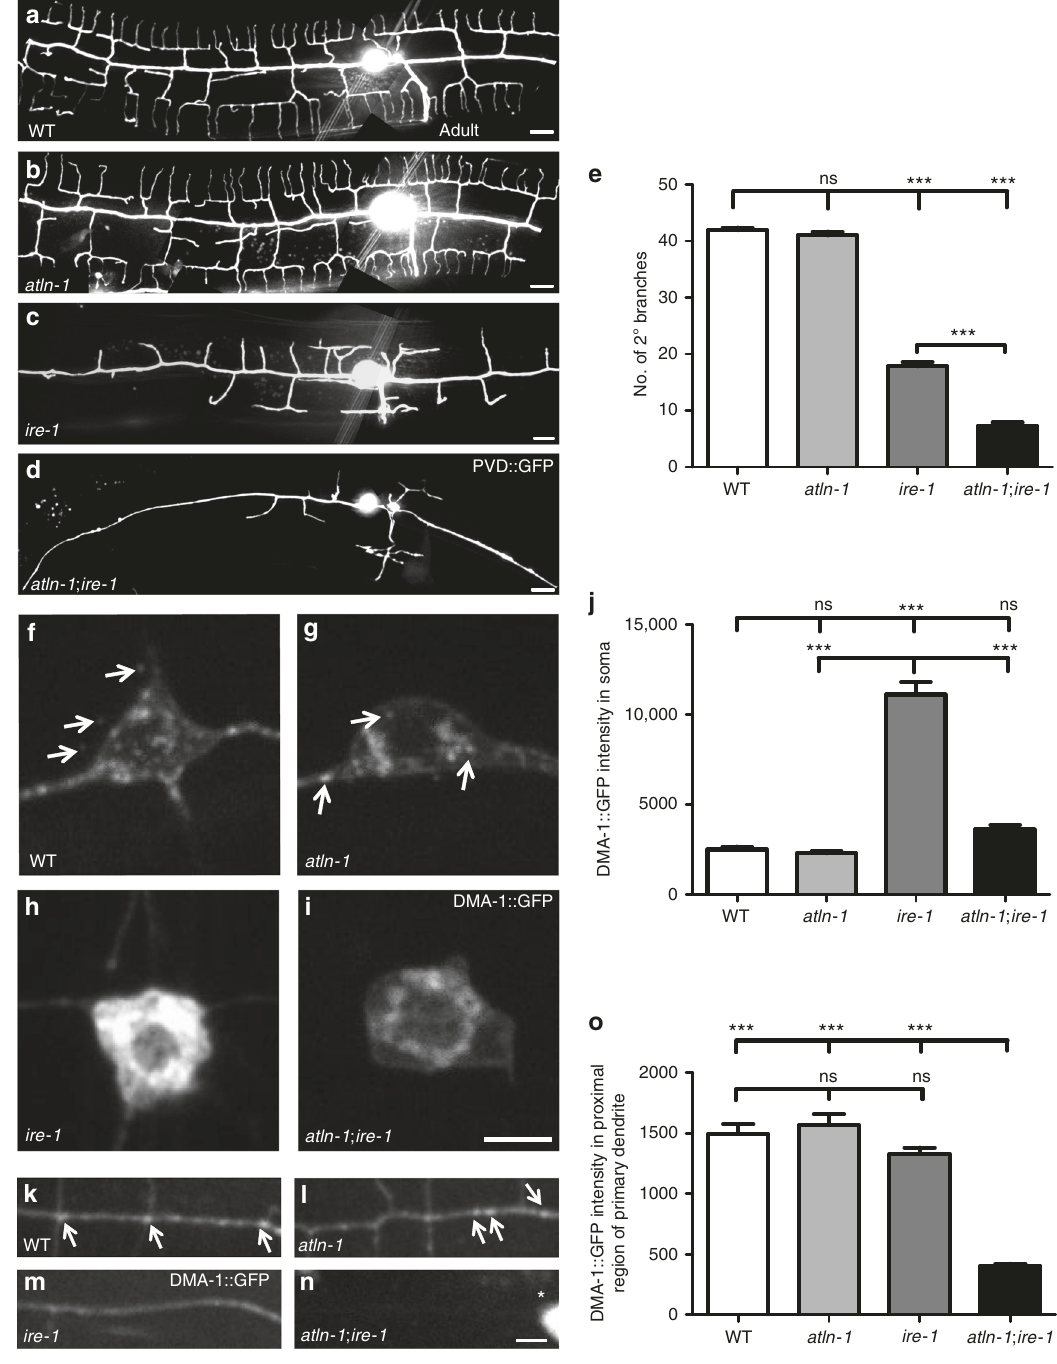
Fig. 7 a tln-1 functions synergistically with ire-1 . a – d Representative confocal images of PVD ( ser-2 P3::GFP) morphology in WT ( a ), atln-1 ( b ), ire-1 ( ok799 ) ( c ) and atln-1; ire-1 ( d ) worms at adult stage. Scale bars, 10 μ m. e Quanti fi cation of the number of PVD 2° branches. Values are mean and error bars are SEM, n > 40. ns, not signi fi cant; *** p < 0.001 (Newman-Keuls multiple comparison test). f – i Confocal images of DMA-1::GFP in PVD cell body in WT ( f ), atln-1 ( g ), ire-1 ( h ), and atln-1; ire-1 ( i ) worms. Arrows indicate DMA-1::GFP puncta. Scale bar, 5 μ m. j Quanti fi cation of DMA-1::GFP fl uorescence intensity in PVD cell body. Values are mean and error bars are SEM, n = 40 – 50. ns, not signi fi cant; *** p < 0.001 (Newman-Keuls multiple comparison test). k – n Confocal images of DMA-1::GFP in anterior primary dendrite around the PVD soma in WT ( k ), atln-1 ( l ), ire-1 ( m ), and atln-1; ire-1 ( n ) worms. Arrows indicate DMA-1::GFP puncta. Asterisk marks cell body. Scale bar, 5 μ m. o Quanti fi cation of DMA-1::GFP fl uorescence intensity of primary dendrites in ( k – n ). Values are mean and error bars are SEM, n = 40 – 50. ns, not signi fi cant; *** p < 0.001 (Tukey ’ s multiple comparison